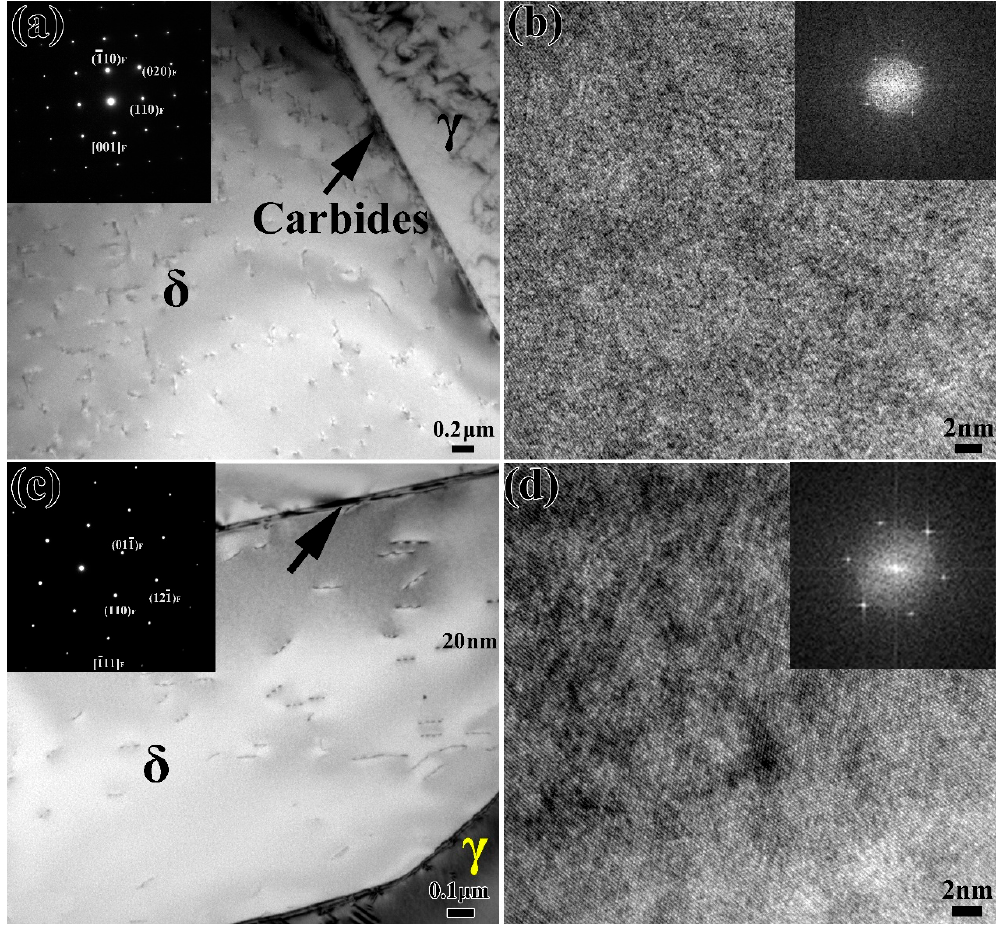
Figure 3. TEM and HRTEM images of stainless steel after aging for ( a , b ) 0 h and ( c , d ) 1000 h; the corresponding SAED and FFT patterns are inserted.